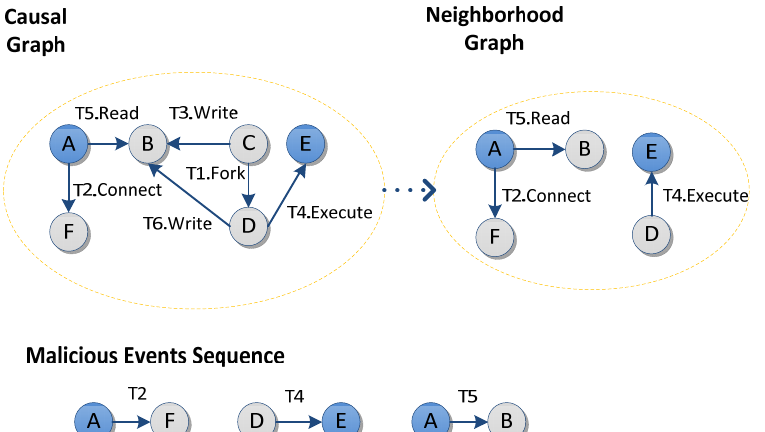
Figure 5. Neighborhood graph. It is an example of generating a neighborhood graph ( right ) from a causal graph ( left ). Two malicious entities {A, E} are contained, while the others such as {B, C, D, F} ( left ) and {B, D, F} ( right ) are non ‐ malicious entities.